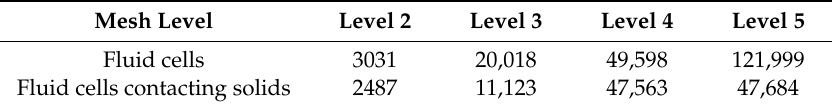
Table 4. Levels mesh